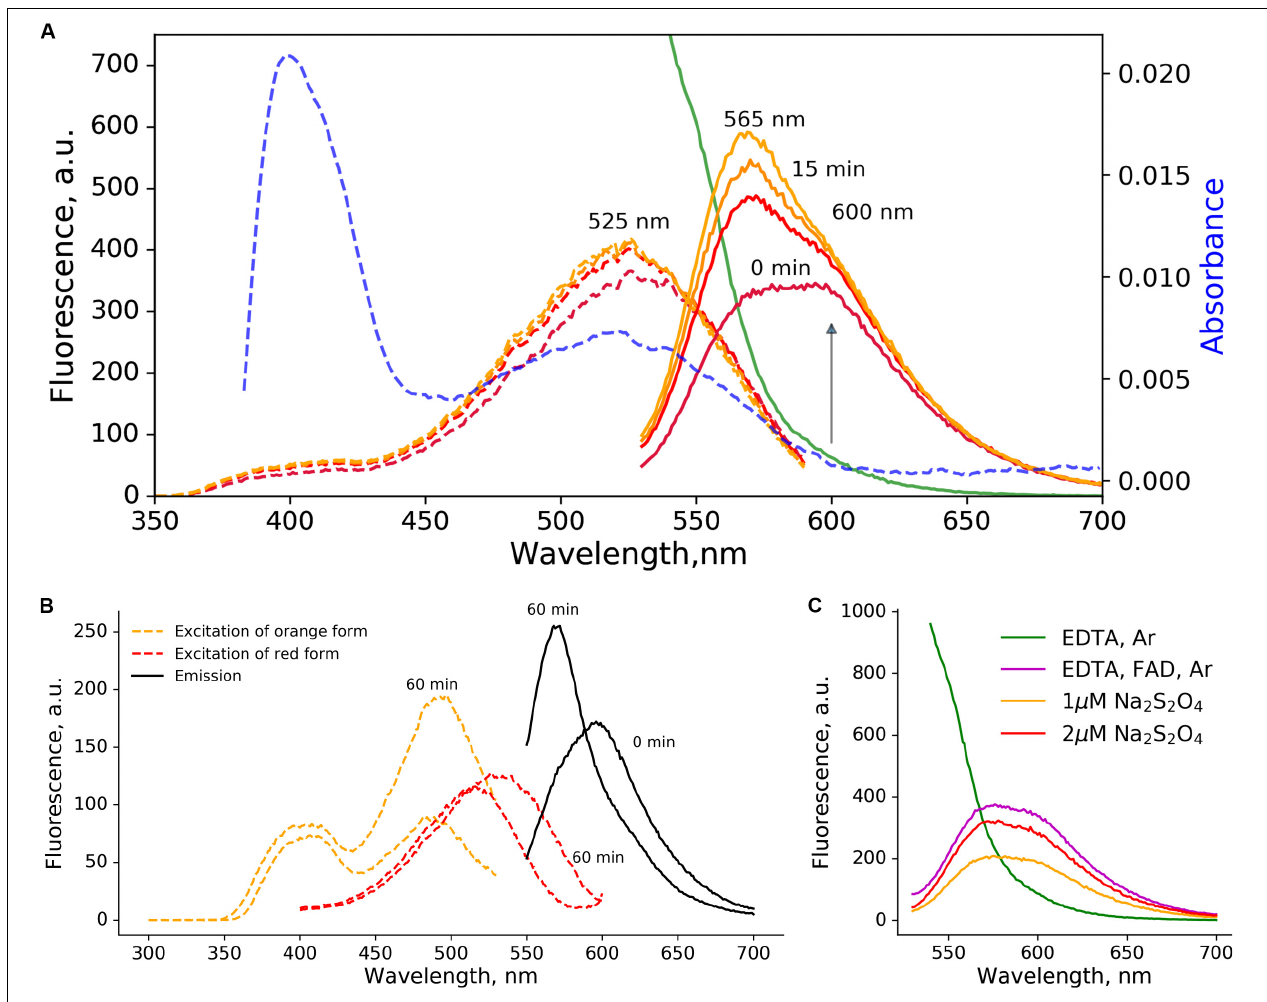
FIGURE 1 | Orange and red-emitting photoproducts of low-oxygen photoconversion of EGFP. The 2 µ M solution of EGFP in the presence of sodium dithionite (10 mM) was illuminated for 5 min with blue light (470 nm, 600 mW/cm 2 ). (A) Fluorescence emission spectra (excitation at 520 nm, solid lines): green – before the photoconversion, from purple to yellow – 0, 5, 10, and 15 min after the photoconversion. The blue dashed line – absorbance after the photoconversion. The purple-to-orange dashed lines – excitation spectra (emission at 620 nm), color-coded similarly to the emission spectra. (B) changes in excitation (dashed lines, orange – for emission at 540 nm, red – for emission at 610 nm) and emission (solid black line, excitation at 540 nm) spectra with time; (C) emission spectra (excitation at 520 nm) of irradiated EGFP samples (5 min, 470 nm, 600 mW/cm 2 ). In the absence of reductants (no FAD, green line) no red-emitting forms are visible even in low-oxygen conditions induced by Ar bubbling. Addition of FAD (magenta line, 10 mM EDTA, 5 µ M FAD) or sodium dithionite (orange and red lines) without Ar treatment results in similar